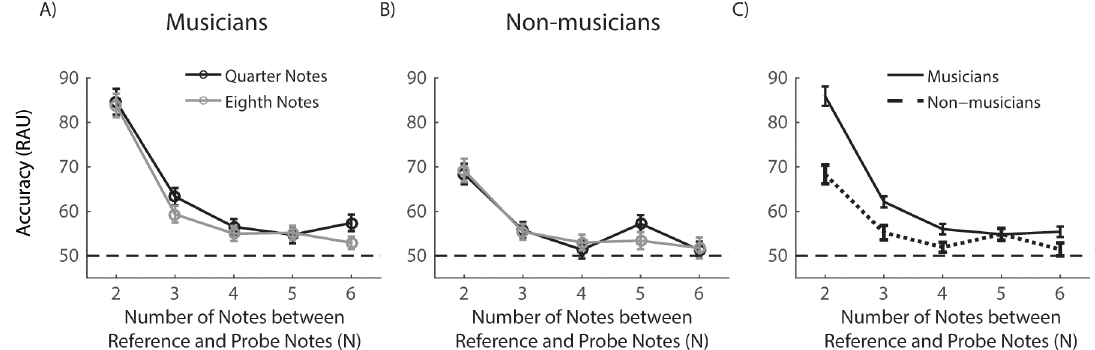
Fig 4. Results of N-back tonal task. ( A , B ) Performance of musicians ( A ) and non-musicians ( B ) as a function of the notes between the reference and probe notes (N) for quarter note (black curve) and eighth note (grey curve) conditions. ( C ) Combined analyses of the quarter and eighth note conditions. Horizontal dashed lines in all plots represent the chance level. Error bars are corrected S.E.M across participants. Stars mark the significant difference comparing to the chance level.